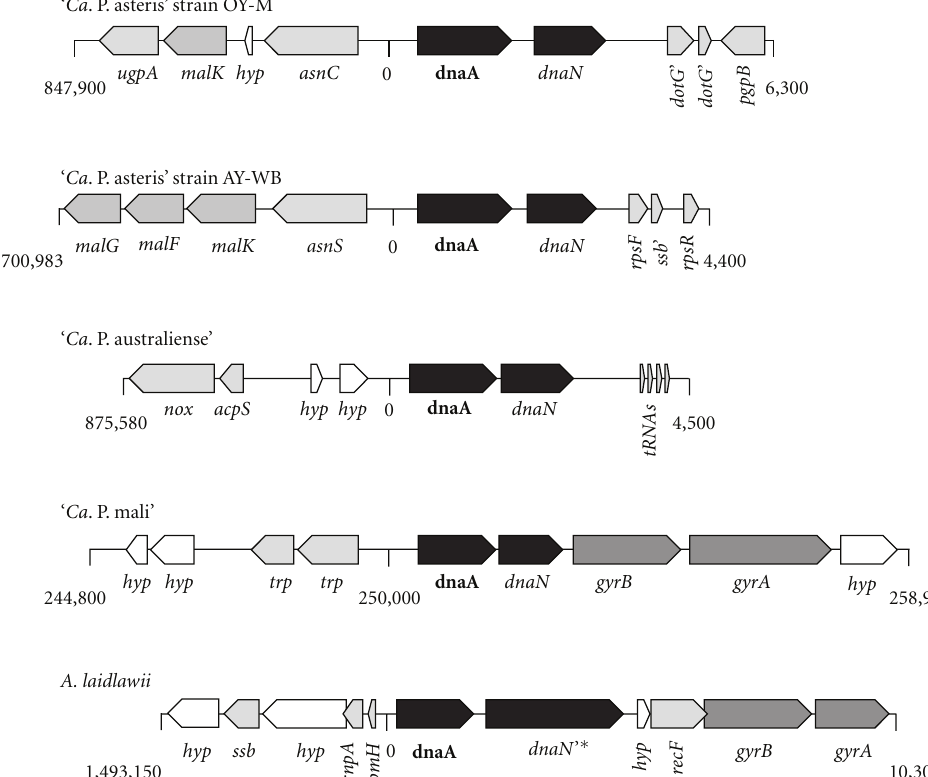
Figure 4: Genomic context at the suggested oriC . The oriC region is shown for the four phytoplasma chromosomes and A. laidlawii illustrating the weak conserved synteny within this region. Several genes are truncated (“ ‘ ”) and one gene probably destroyed by transposase integration (“ ∗ ”). Abbreviation of genes: hyp: hypothetical protein; trp: ABC transporter subunit. Genome positions were given for each region taking in account the circular organisation of four